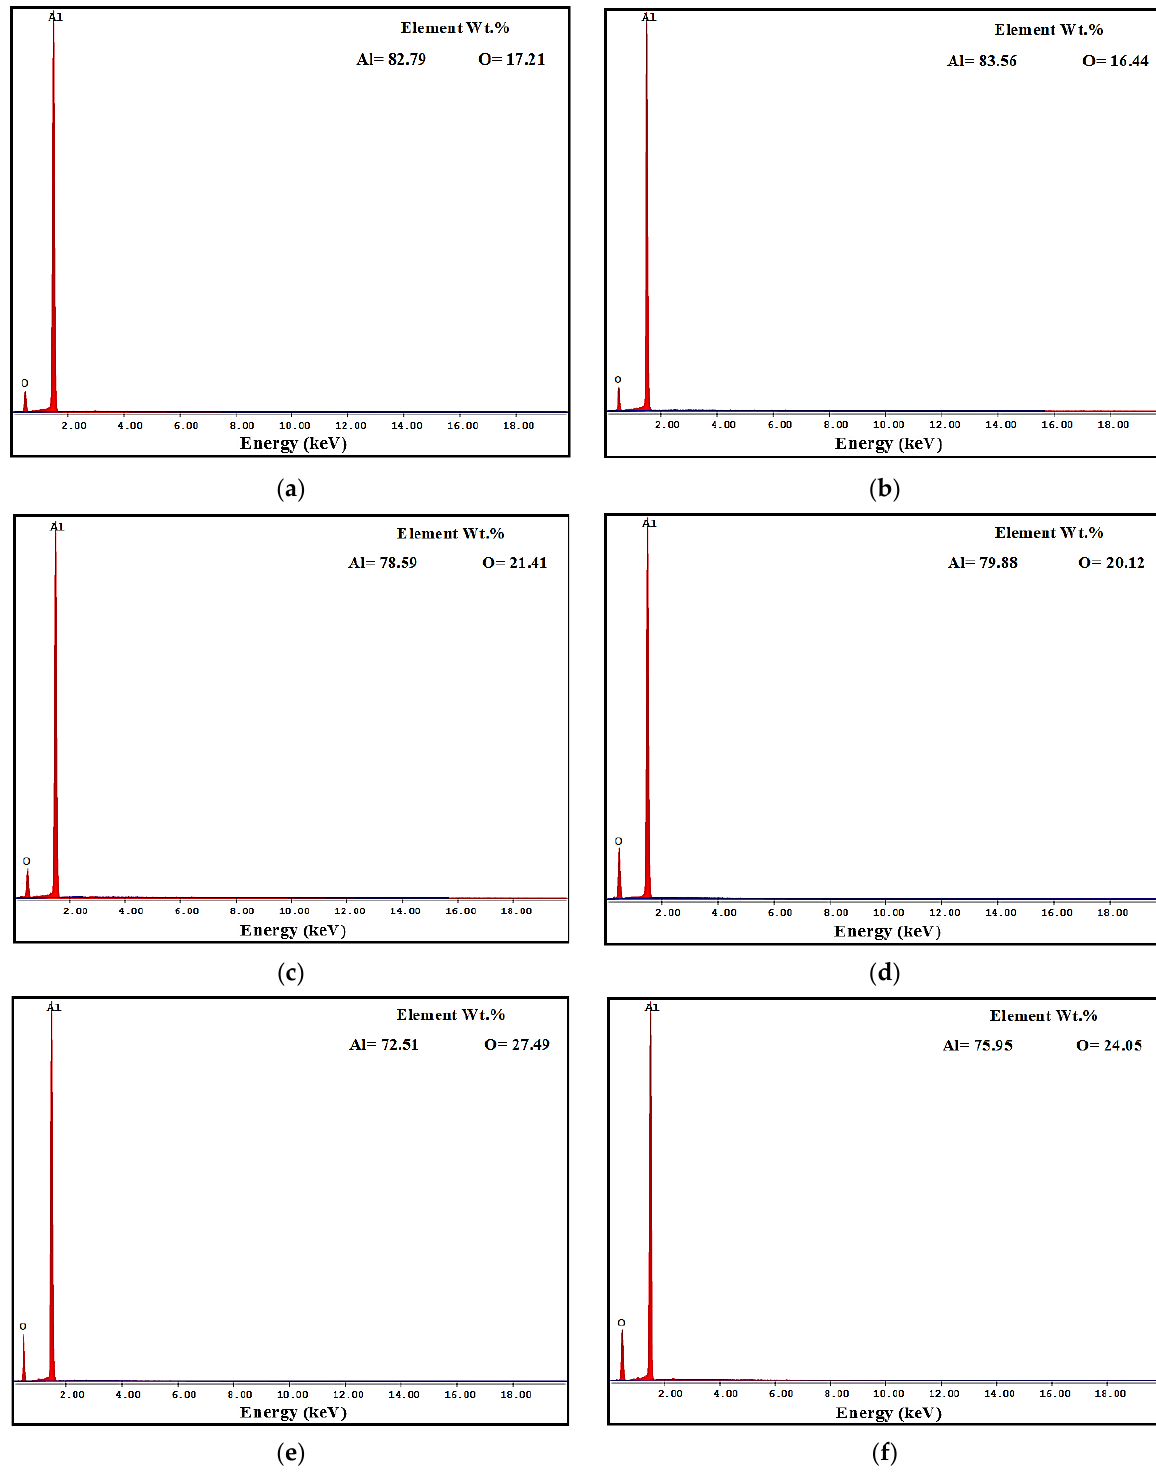
Figure 8. EDS analysis of worn surface morphology of ( a , c , e ) PM Al and ( b , d , f ) of HPT-processed Al samples ( a , b ) under an applied load of 2.5 N and a sliding distance of 315 m, ( c , d ) under an applied load of 20 N and a sliding distance of 315 m, and ( e , f ) obtained under an applied load of 20 N and a sliding distance of 1260 m. The PM Al MMCs wear mechanisms were adhesive, delamination (shown by red arrows), and shear streams along the sample (shown by black arrows) (Figure 9a,b). The delamination and adhesive degree of wear decreased after the HPT processing due to the